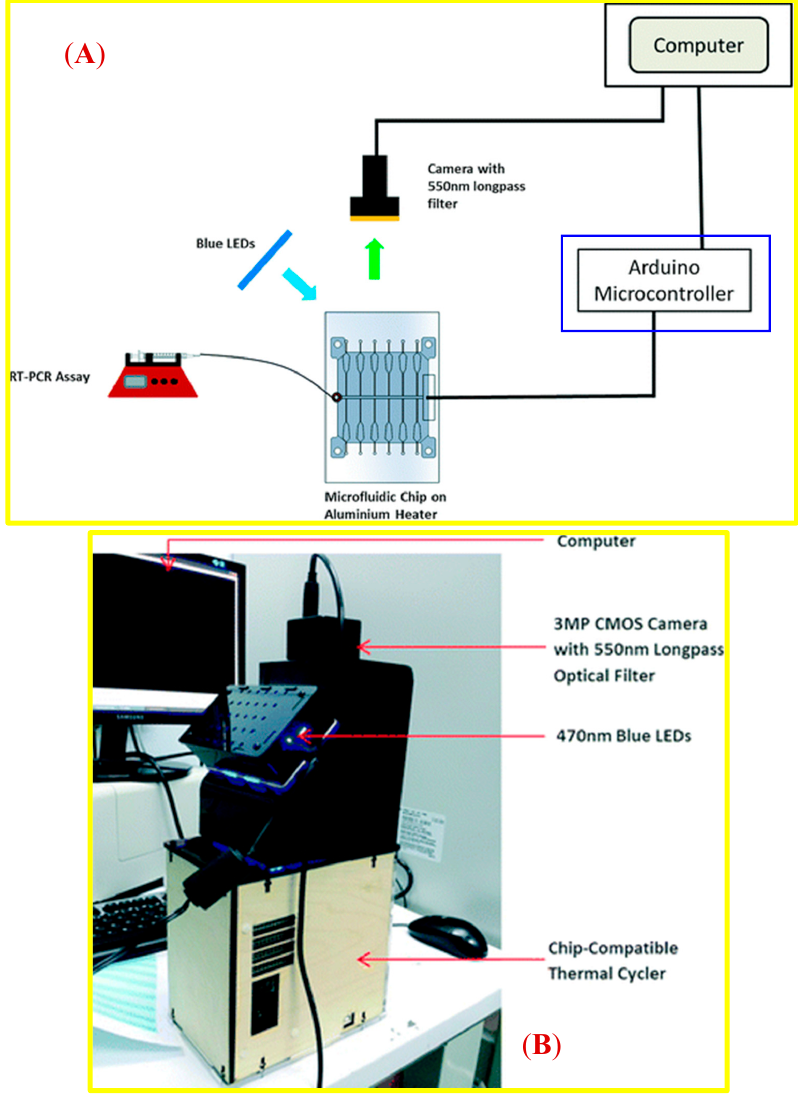
Figure 4. An example of using an Arduino board (denoted in the blue rectangle) for measurement and control temperature in a LoC system ( A ), and as a PoC prototype ( B ). Published in Lab on a Chip journal by Lim et al. Reproduced with permission from [24].